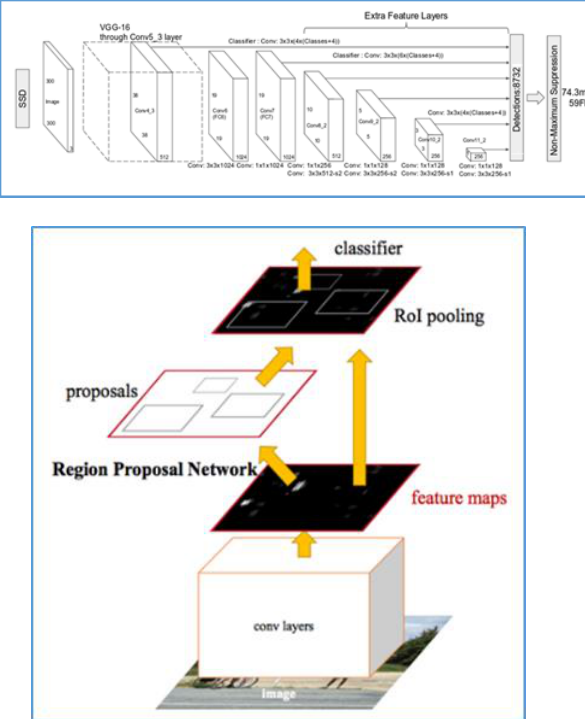
Figure 2. Single stage and Two stage DL